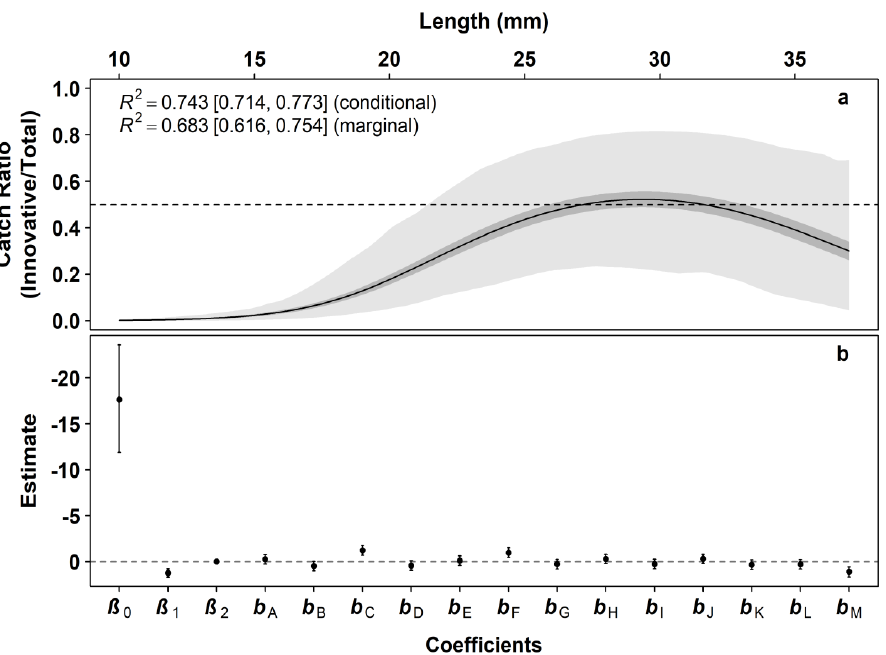
Figure 5. Visualization of model posterior predictions of catch ratio for a new, randomly generated haul (continuous for the range of clam lengths present in the samples) and coefficients. ( a ) The solid black line corresponds to the mean of the 100 posterior draws, while the dark gray shade indicates the area of mean ± 2 SE. The light gray shade indicates the 90% credible intervals for the posterior values. The dashed line corresponds to the 0.5 catch ratio (i.e., equal probability of catch between gears). Finally, the Bayesian R 2 values are reported with 90% credible intervals, with “conditional” referring to the variance of the complete model and “marginal” only to the fixed part, excluding the random effects (i.e., hauls). ( b ) Model coefficients with 90% credible intervals (please note the in- verted Y axis). The dashed line marks 0. Greek β 0 to β 2 labels correspond to the fixed effects, while b A to b M to the random intercept effect of each haul, respectively.